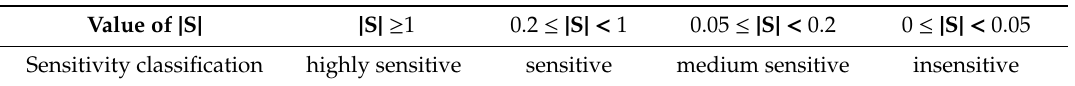
Table 9. Sensitivity classification.